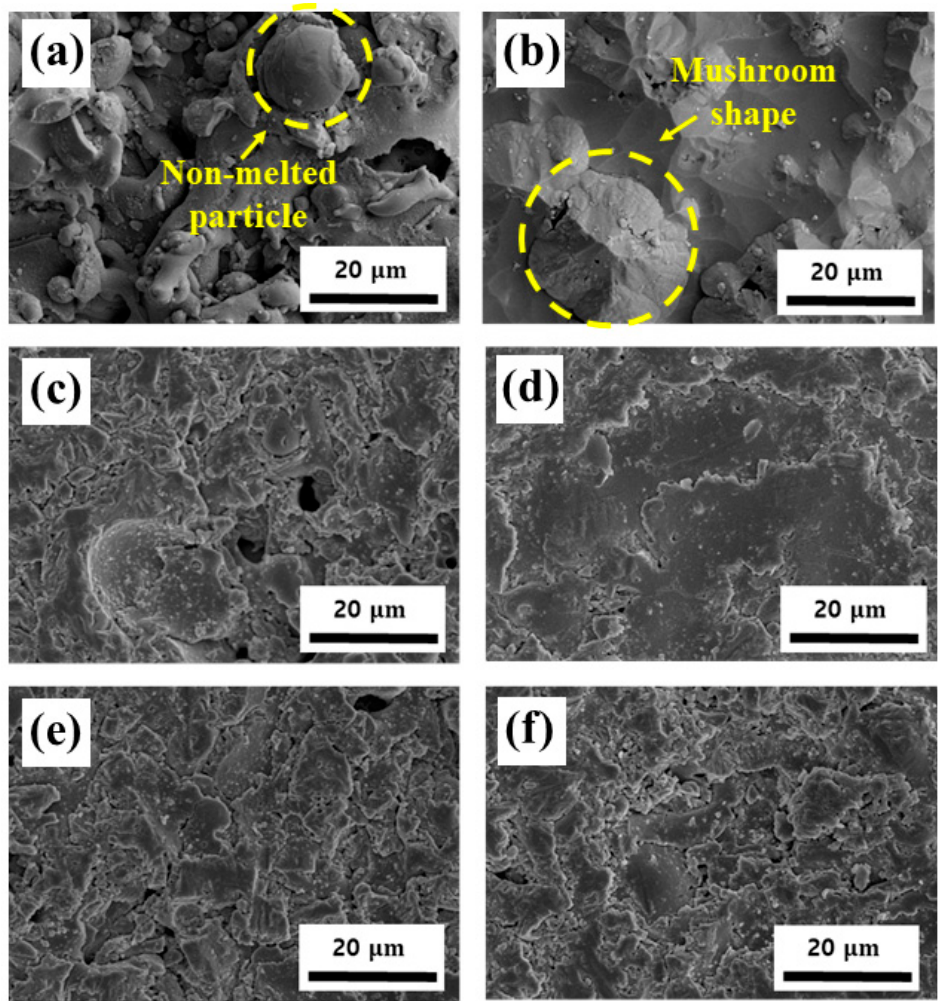
Figure 5. FE-SEM images of the surface of APS–Y 2 O 3 coatings; ( a ) pristine APS–Y 2 O 3 , ( b ) APS–Y 2 O 3 plasma exposure and after cleaning with piranha solutions with ratios of ( c ) 2:1, ( d ) 3:1, ( e ) 4:1, and ( f ) 5:1.